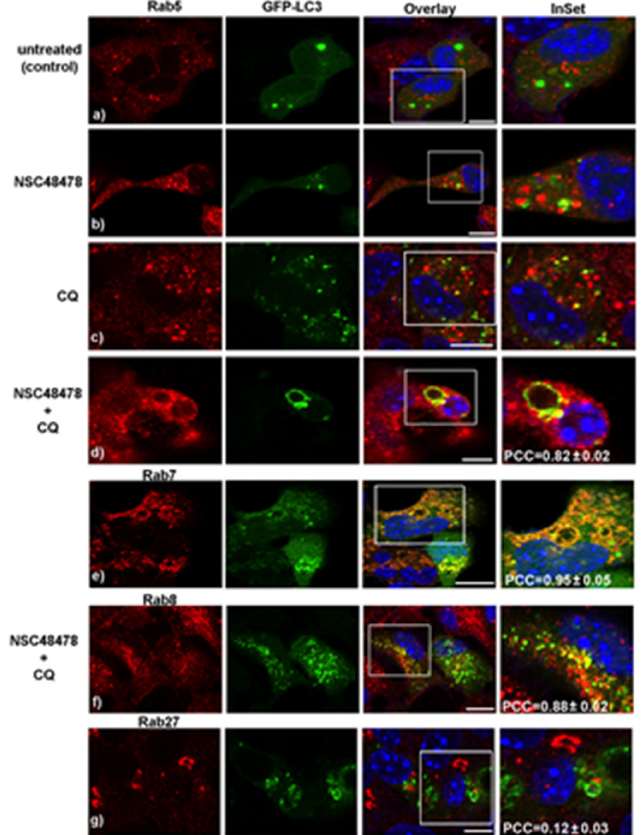
Figure 3. Rab proteins of the endocytic pathway, together with Rab of the recycling route, but not the secretory Rab27, participate in the formation of LC3-positive membranes. GT1 cells, treated as indicated, were processed for immunofluorescence as in Figure 2, with the exception that here, anti-Rab5 (panels a – d ), anti-Rab7 (panel e ), anti-Rab8 (panel f ) and Rab27 (panel g ) were used to measure the colocalization with GFP-LC3. PCC ( ± SEM) was calculated as described in methods. Scale bars: 10 µ